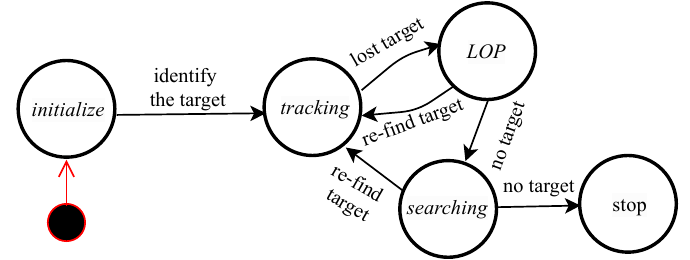
Figure 1. State machine diagram for the proposed human following